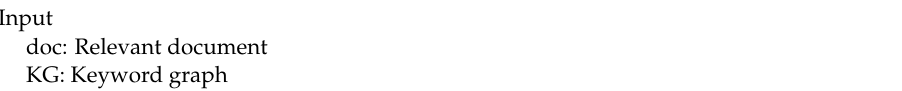
Algorithm 1 AnalysisRelevantDocuments(doc, KG)